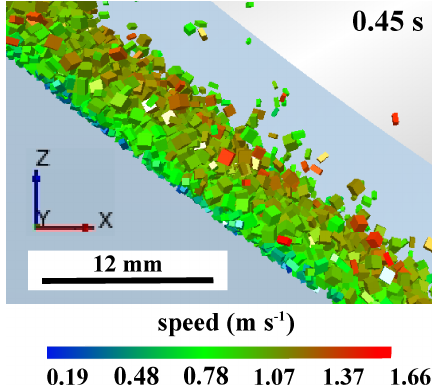
Figure 6. Side view of a granular flow. Particle speed decreases toward the subsurface along its normal. In this example the granular mass is 26g, the grain size is 1mm, w is 6mm and θ is 27 ◦ . The time measured in seconds is that elapsed since the gate